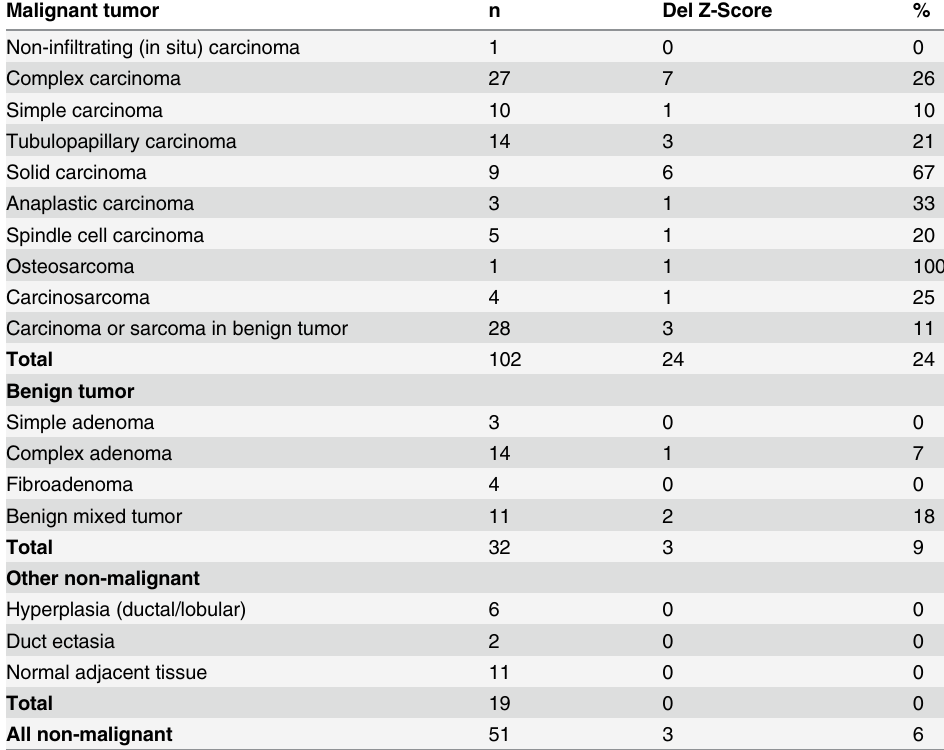
Table 1. PFDN5 deletion in different tumor